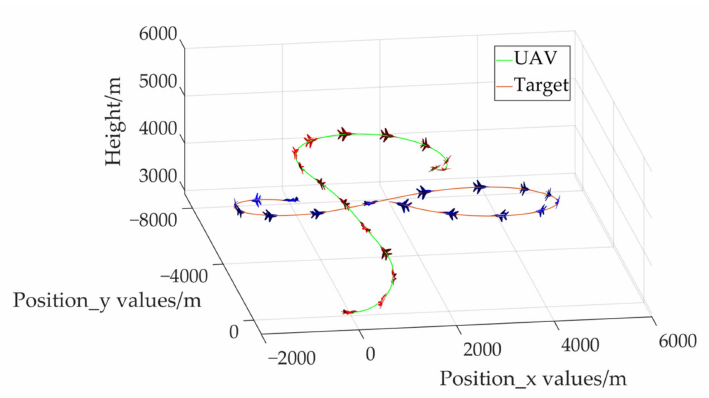
Figure 10. Air combat three-dimensional trajectory of two aircraft in case 2.